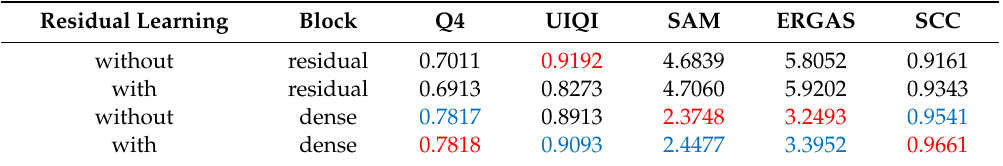
Table 11. Quantitative evaluation results of di ff erent architectures on the GaoFen-2 dataset. The best and the second best results are in red and blue, respectively.